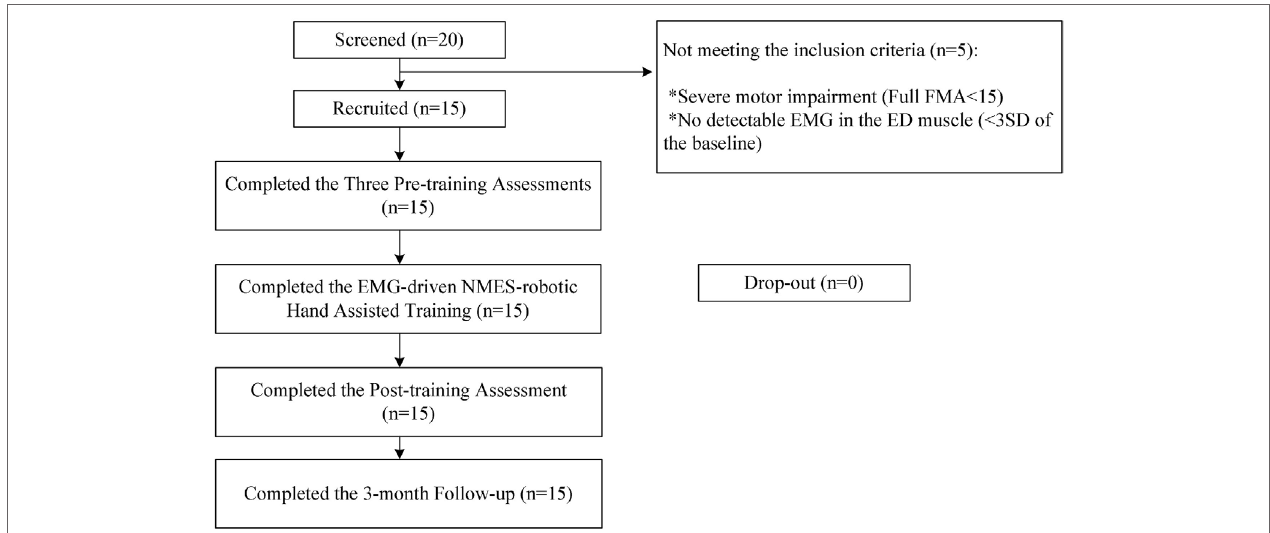
FiGUrE 2 | The Consolidated Standards of Reporting Trials flowchart of the experimental